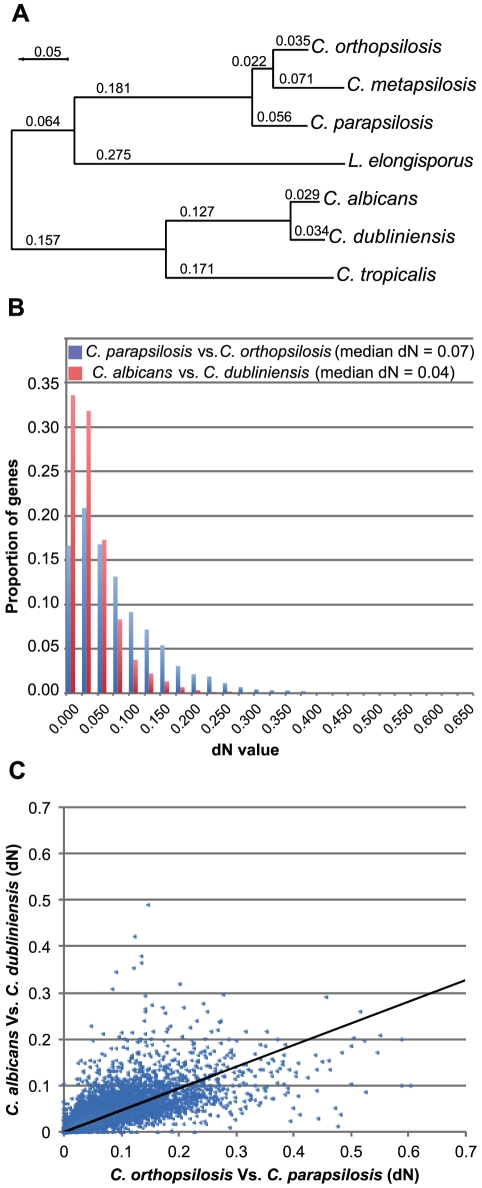
Phylogeny and sequence divergence in the C. orthopsilosis clade.(A) Phylogenetic relationship among 7 species, from maximum likelihood analysis of concatenated partial sequences of 1334 proteins. Numbers indicate branch lengths. Bootstrap values on all branches are 100%. (B) Histogram of distributions of nonsynonymous substitution levels (dN) in 5091 orthologous genes for two independent interspecies comparisons (C. orthopsilosis vs. C. parapsilosis, and C. albicans vs. C. dubliniensis). (C) Scatter plot showing the correlation of dN values for individual genes in the same two comparisons. The regression line has been forced through the origin.